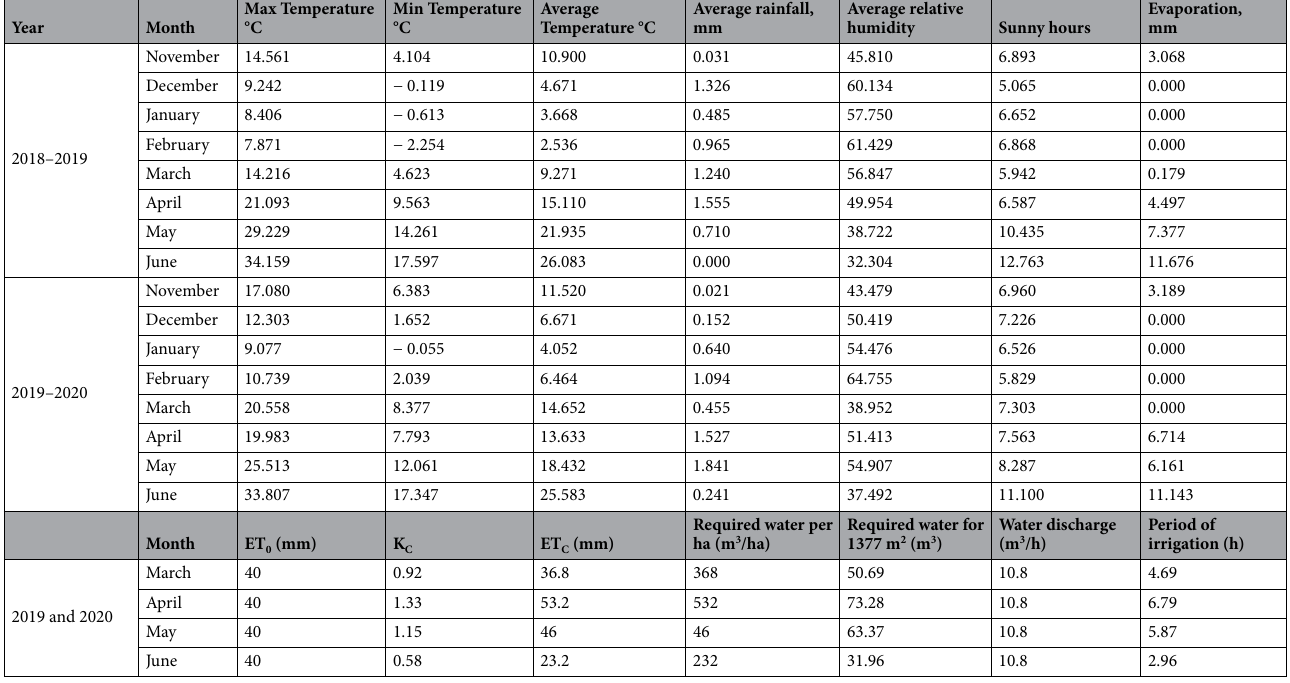
Table 4. Climatic data in the studied environments and pattern of monthly precipitation and irrigation for the 2018–2019 and 2019–2020 cropping